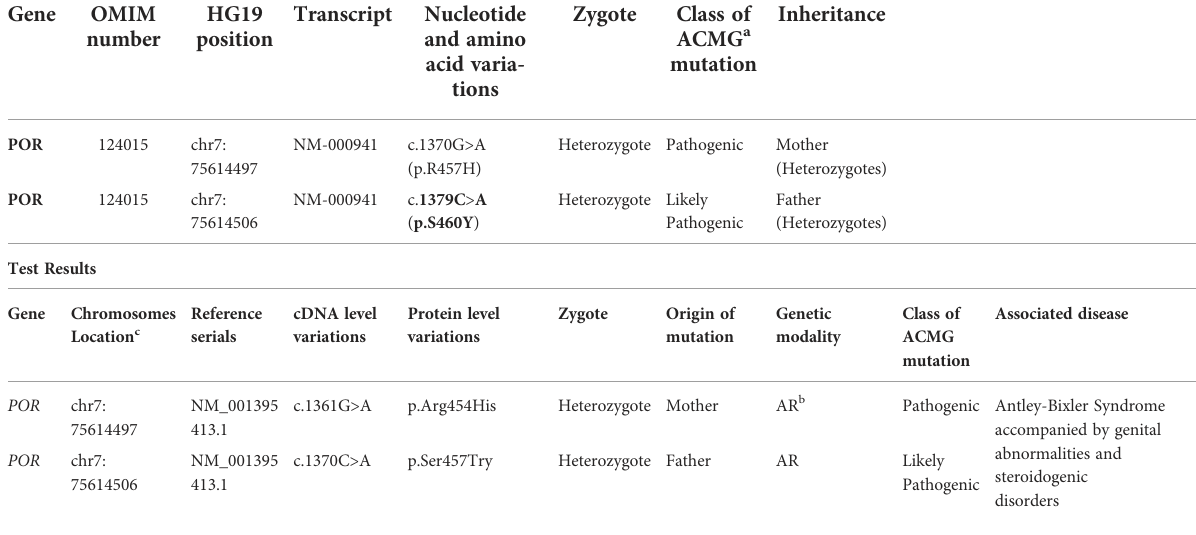
TABLE 2 Genetic test results of Case 1 (the mother), Case 3 (her son) and her